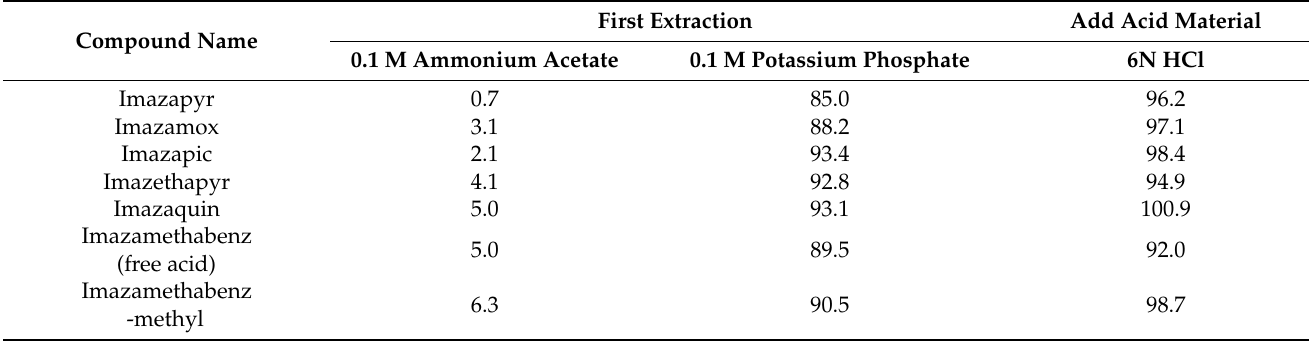
Table 3. Efficiency of extraction solvent towards imidazolinone